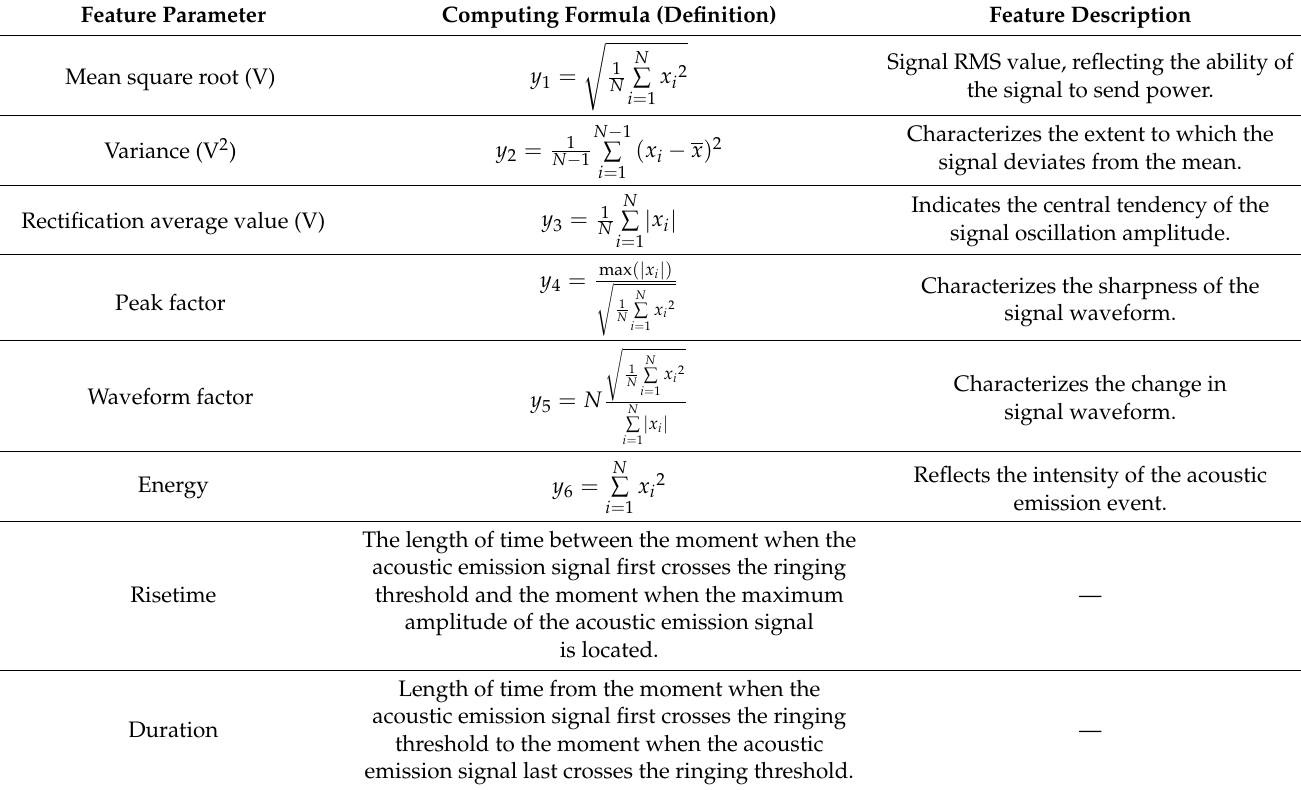
Table 2. Time domain characteristic